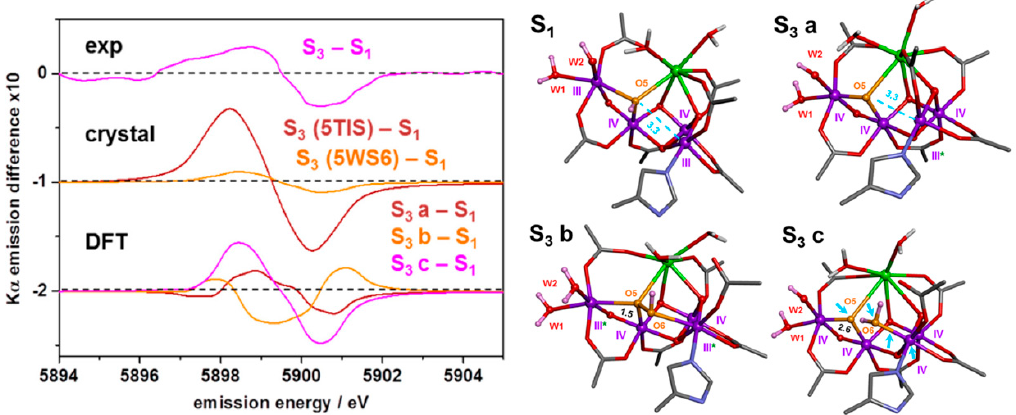
Figure 9. Left: K α S 3 − S 1 difference spectra from experiment (top), from multiple-scattering theory calculations on OEC crystal structures in S 1 (mean of three XFEL structures) and S 3 without (5TIS, Young et al. [124]) and with an O6 atom (5WS6, Suga et al. [46]) (middle), and on DFT structures (bottom). Right: DFT models of the S 1 and the S 3 states used in the simulations: S 3 a assumes no extra ligand binding, S 3 b contains a hydroperoxide, and S 3 c assumes water binding at Mn1. Figures adapted with permission from Schuth et al. [62]. Copyright 2018 American Chemical Society.